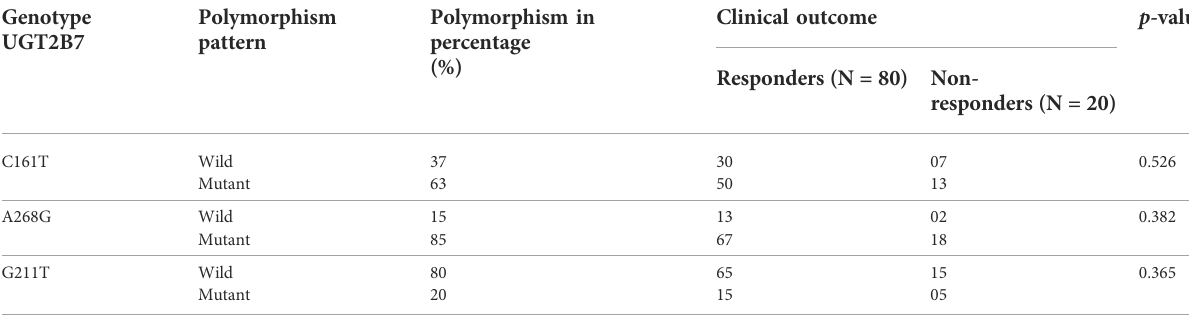
Statistical test used is Chi Square test.